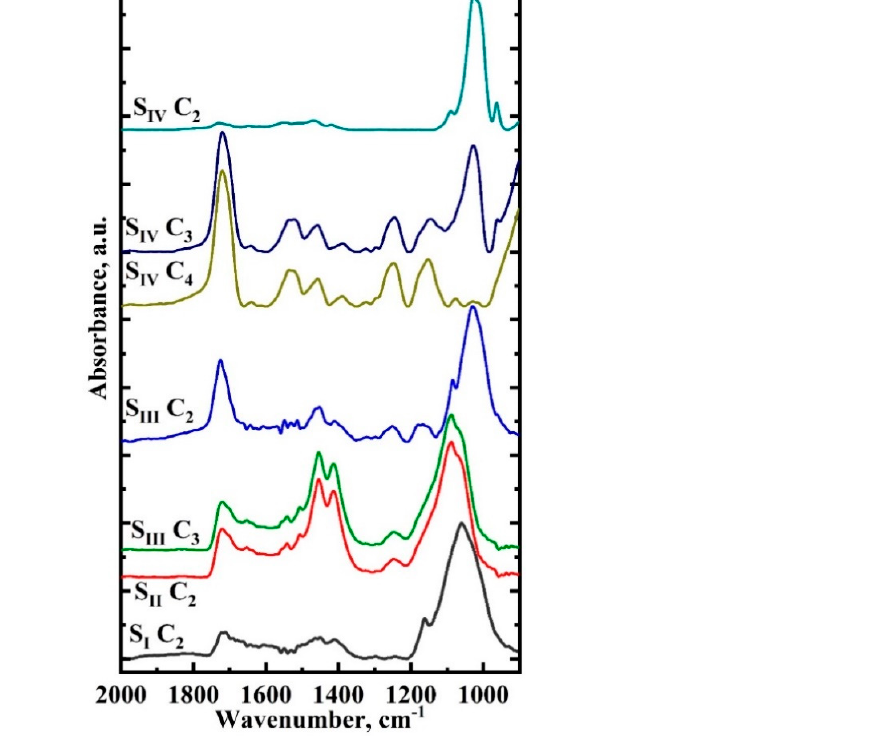
Figure 7. Averaged spectra of clusters belonging to the transition/hybrid layer for each type of samples studied.